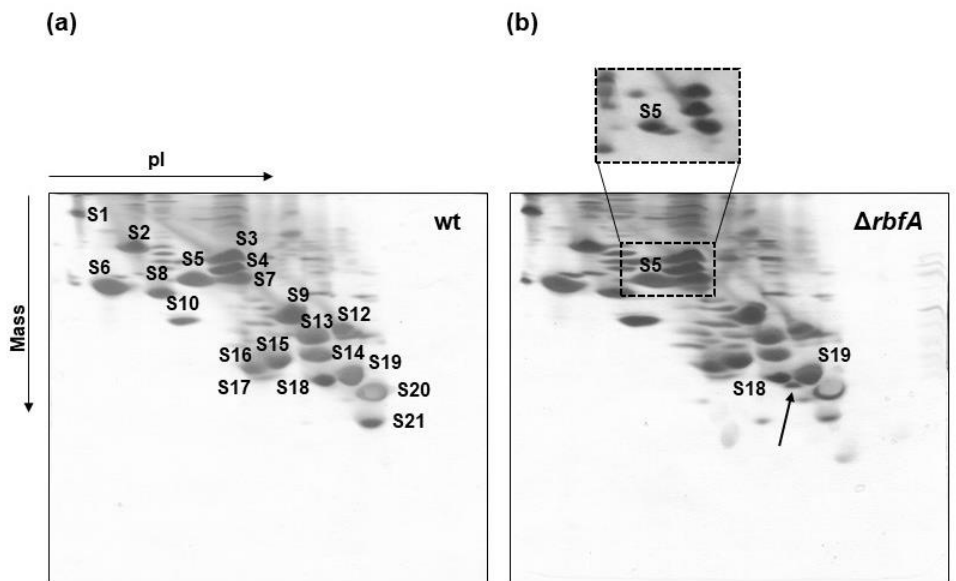
Figure 1. Immature 30S particles of ∆ rbfA strain contain all the r-proteins present in 30S subunits purified from wild-type E. coli cells. Two-dimensional electrophoretic analysis of the protein composition of 30S subunits from wild-type strain ( a ), and from a strain with deleted rbfA gene ( b ). Proteins were separated by pI and by mass in 2D urea gel. The arrow indicates the position of non-acetylated S18. The inset represents the part of a similar gel with less protein loaded which demonstrates splitting of the S5 spot due to incomplete acetylation ( b ).